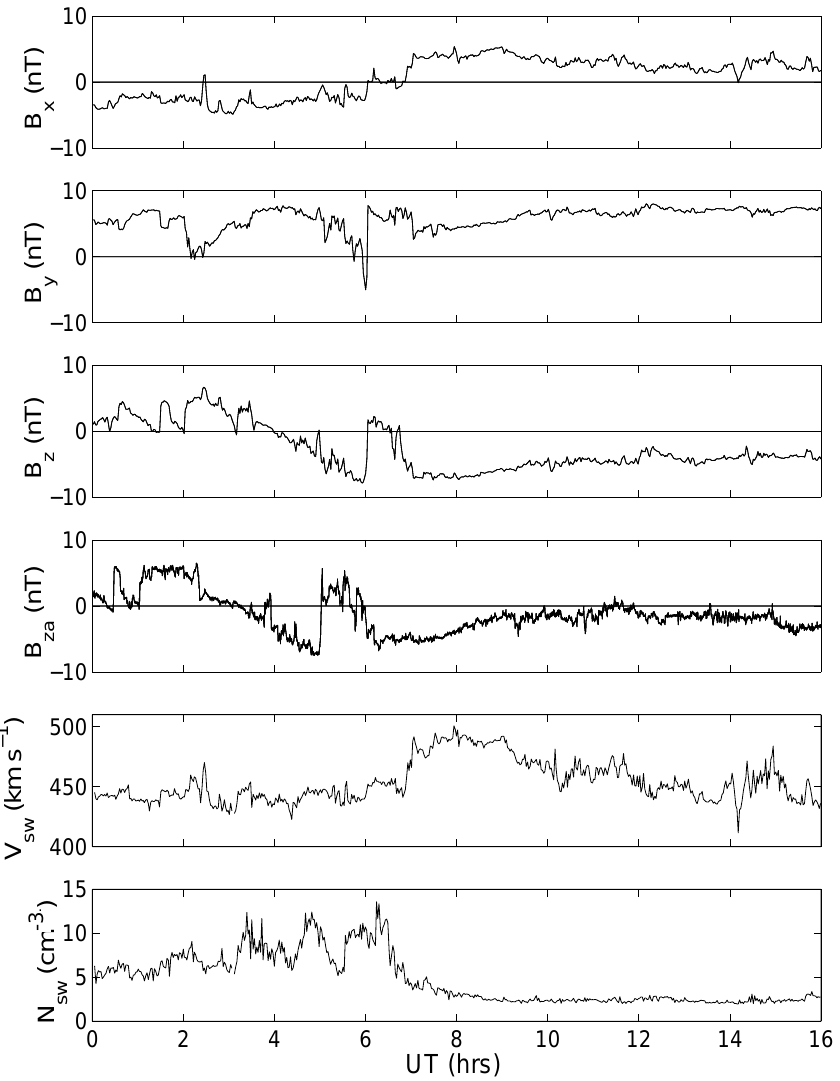
Fig. 1. Summary of solar wind and Interplanetary Magnetic Field (IMF) observations on 23 November 1999. From top to bottom: the IMF components B X , B Y and B Z in the GSM coordinate system, observed by the WIND spacecraft; B Z in the GSE frame observed by the ACE spacecraft; the solar wind speed, V SW , and concentration, N SW , observed by